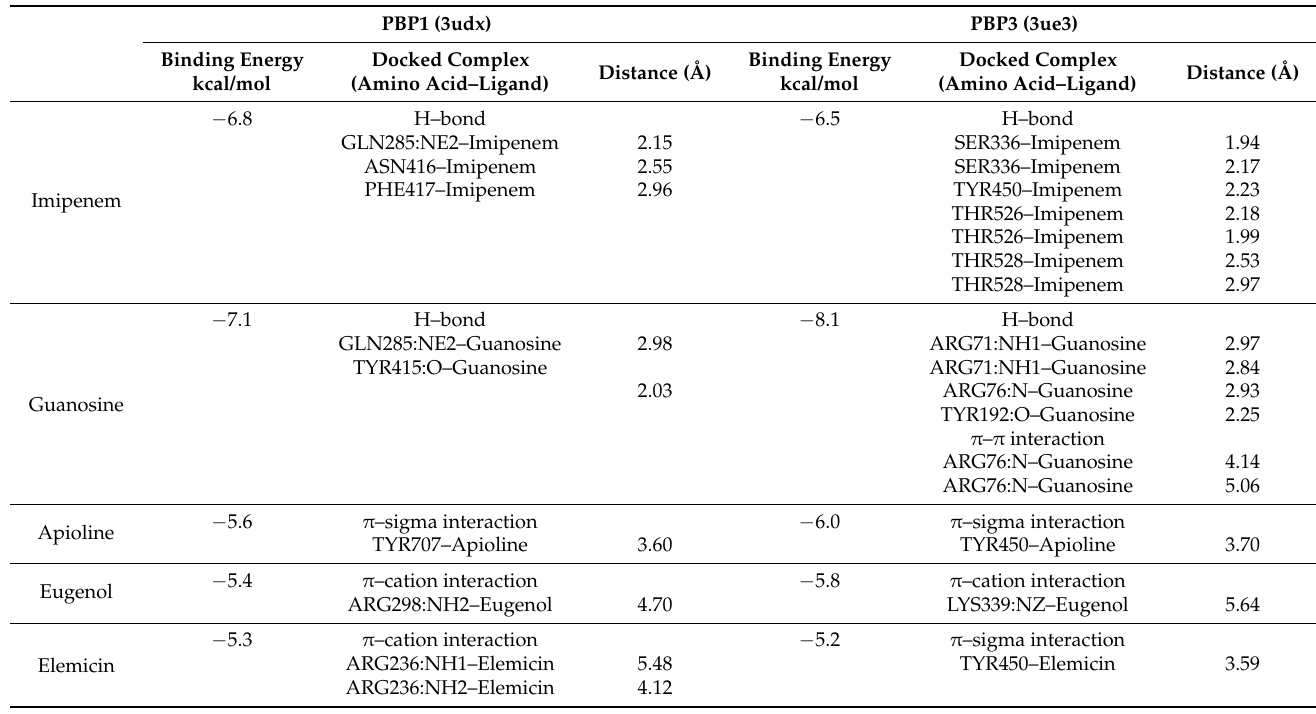
Figure 4. The differences of MIC and MBC values of Imipenem and S. aromaticum different extracts against A. baumannii isolates. Shown are the medians from at least three independent measurements for MIC (blue) and MBC (yellow). S. aromaticum different extracts (100 mg mL − 1 ) ( A ): aqueous extract; ( B ): ethanolic extract; and ( C ): ethyl acetate extract. Imi: Imipenem (10 mg mL − 1 ). The error bars indicate the interquartile range. Significant differences between the data sets are marked by asterisks ( p < 0.05; Kruskal–Wallis test and post hoc Dunn’s multiple comparisons). A1: A8 are the A. baumannii isolates codes. A1: isolates from urine sample; A5: from wound samples; A2, A3, A6, and A8 for respiratory sample. Table 4. The binding affinity (kcal/mol) of some phyto-compounds and Imipenem with PBP1 and PBP3 after molecular